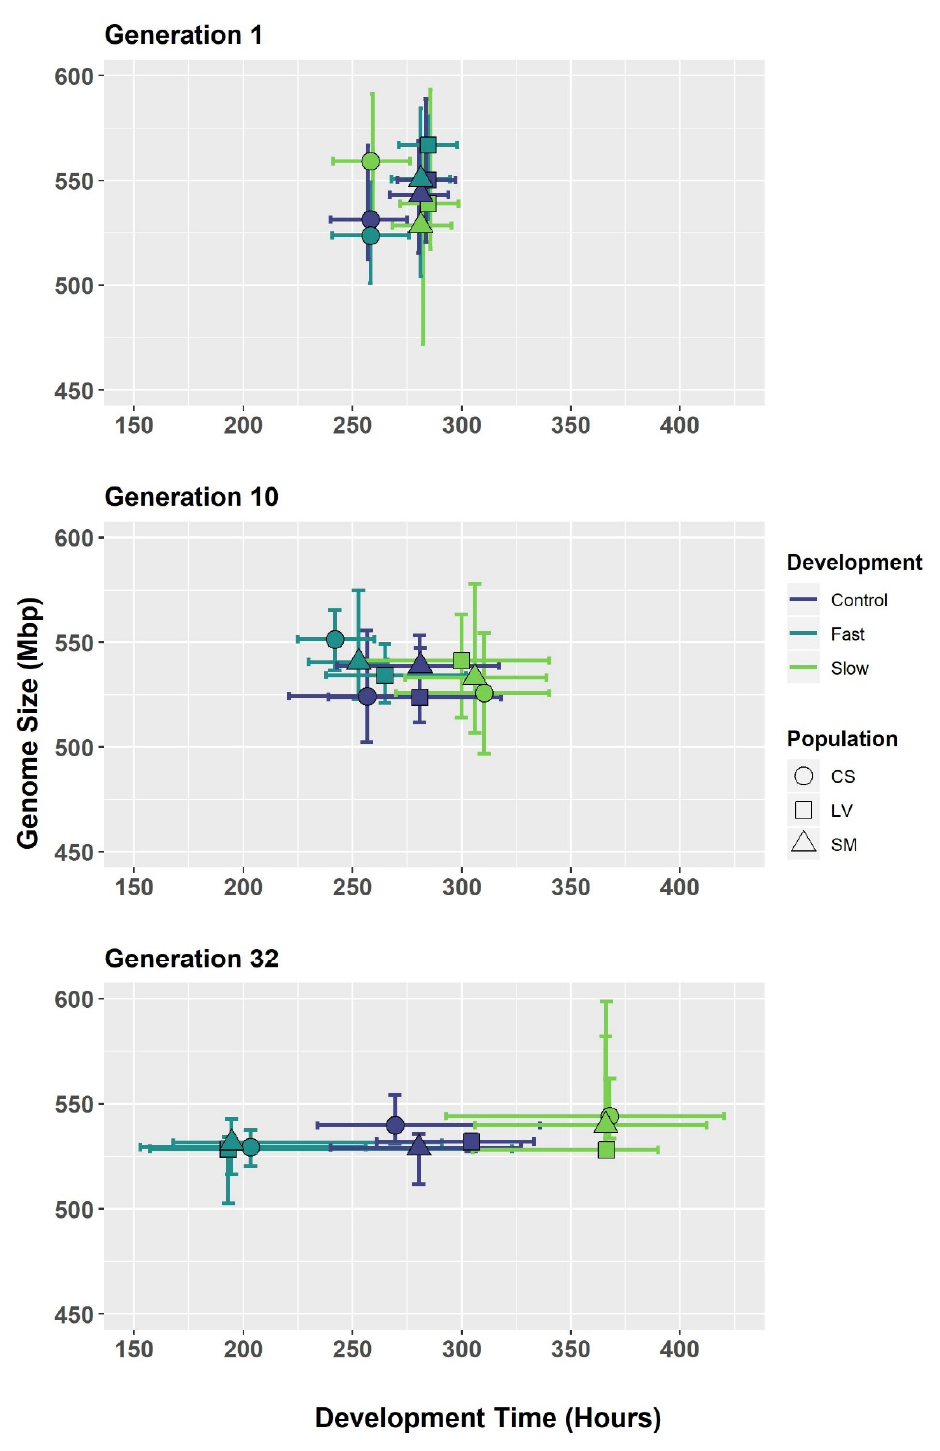
Figure 1. Range of development time and genome size for generations 1, 10, and 32 for different populations of the blow fly Cochliomyia macellaria . Hours of development time are plotted on the X -axis and genome size (Mbp) is plotted on the Y -axis. Points represent mean of the phenotype and lines represent the range of each trait. Colors represent development and shapes represent origin city. No change in development time by generation was seen in control lines, increases in development time was seen in slow selected lines, and decrease in development time was seen in fast selected lines. Variation in genome size reduced with generation and converged on a mean size of approximately 530 Mbp. Variation in development time increased from generation one and was maintained.